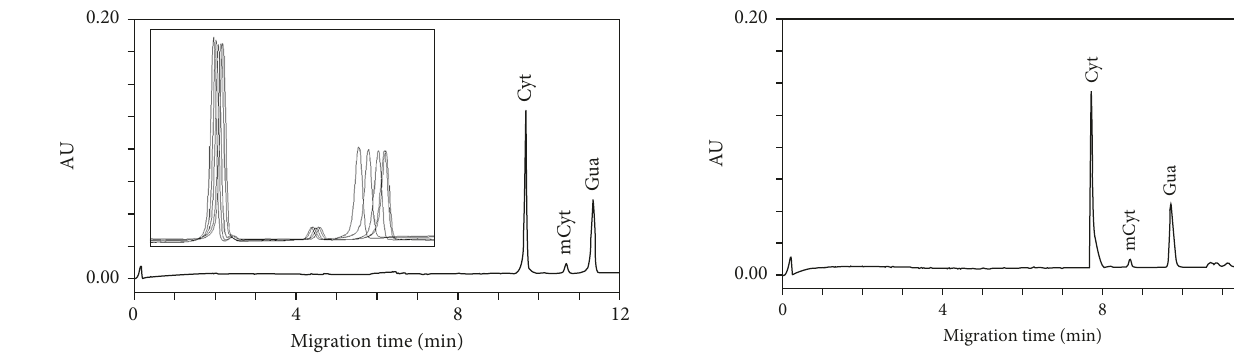
Figure 2: Typical electropherogram of the DNA sample extracted from whole human blood after formic acid hydrolysis obtained with 60mmol/L sodium acetate buffer at pH 3.60 as the run buffer. Electrophoretical conditions: uncoated silica capillary, 60cm × 100 μ m id; cartridge temperature, 18 ° C; voltage, 22kV; detection, 280nm; hydrodynamic injection, 270nL (2.0psi × 5s). Cyt (cid:136) cytosine; mCyt (cid:136) 5-methylcytosine.